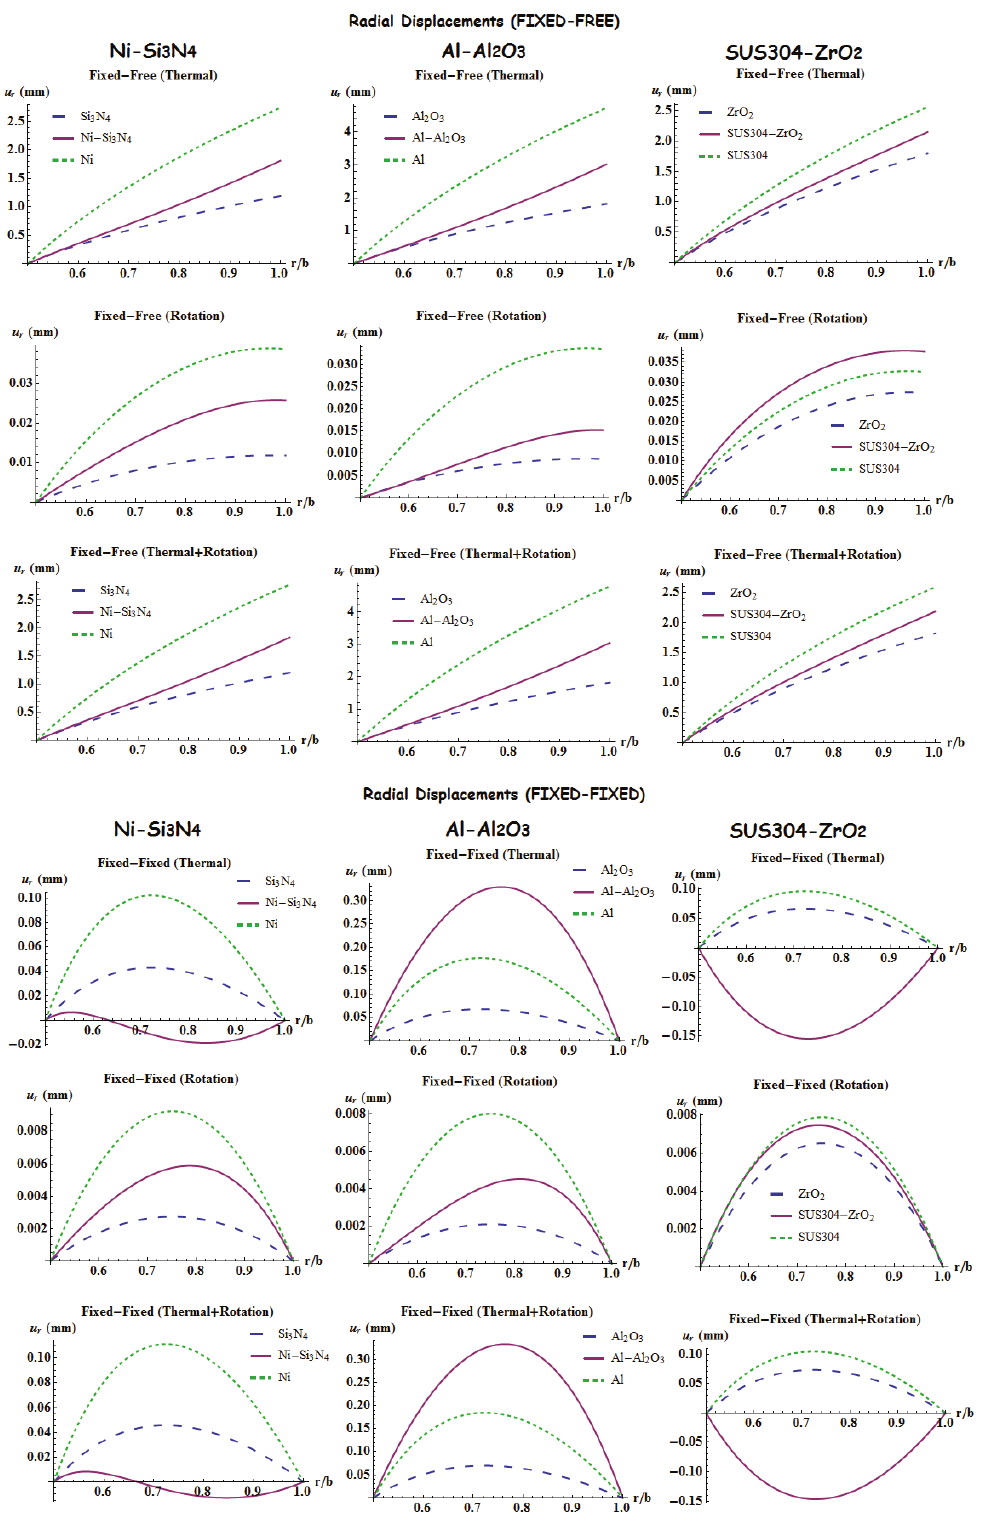
Figure 4. Variation of the radial displacements.